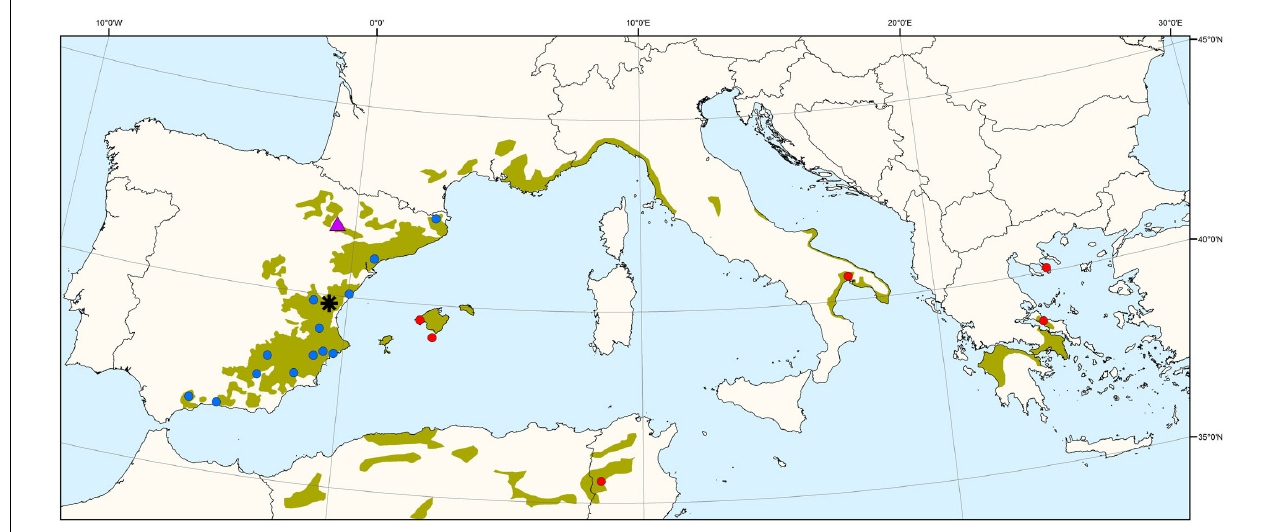
FIGURE 1 | Distribution map of Pinus halepensis source populations (blue circles: 13 Iberian populations; red circles: 6 non-Iberian populations) and common garden experiments (purple triangle: drier site; black asterisk: moister site). The green area indicates the species’ natural distribution range.